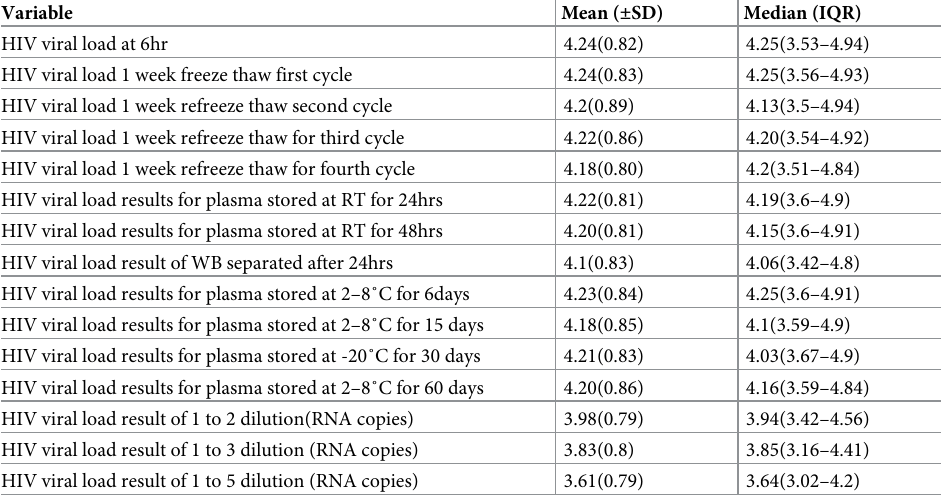
Table 1. Mean and median log copies/ml viral load distribution of participants with different sample handling conditions at Saint Paul’s Hospital Millennium Medical College, 2019.